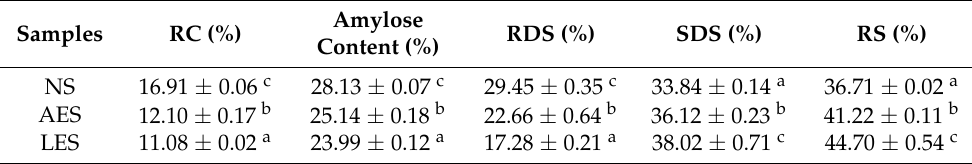
Figure 1. ( a ) FT-IR spectra and; ( b ) XRD of native and organic acid treated talipot starches. Table 1. Relative crystallinity, amylose content and in vitro digestibility of native and organic acid- treated talipot starches.